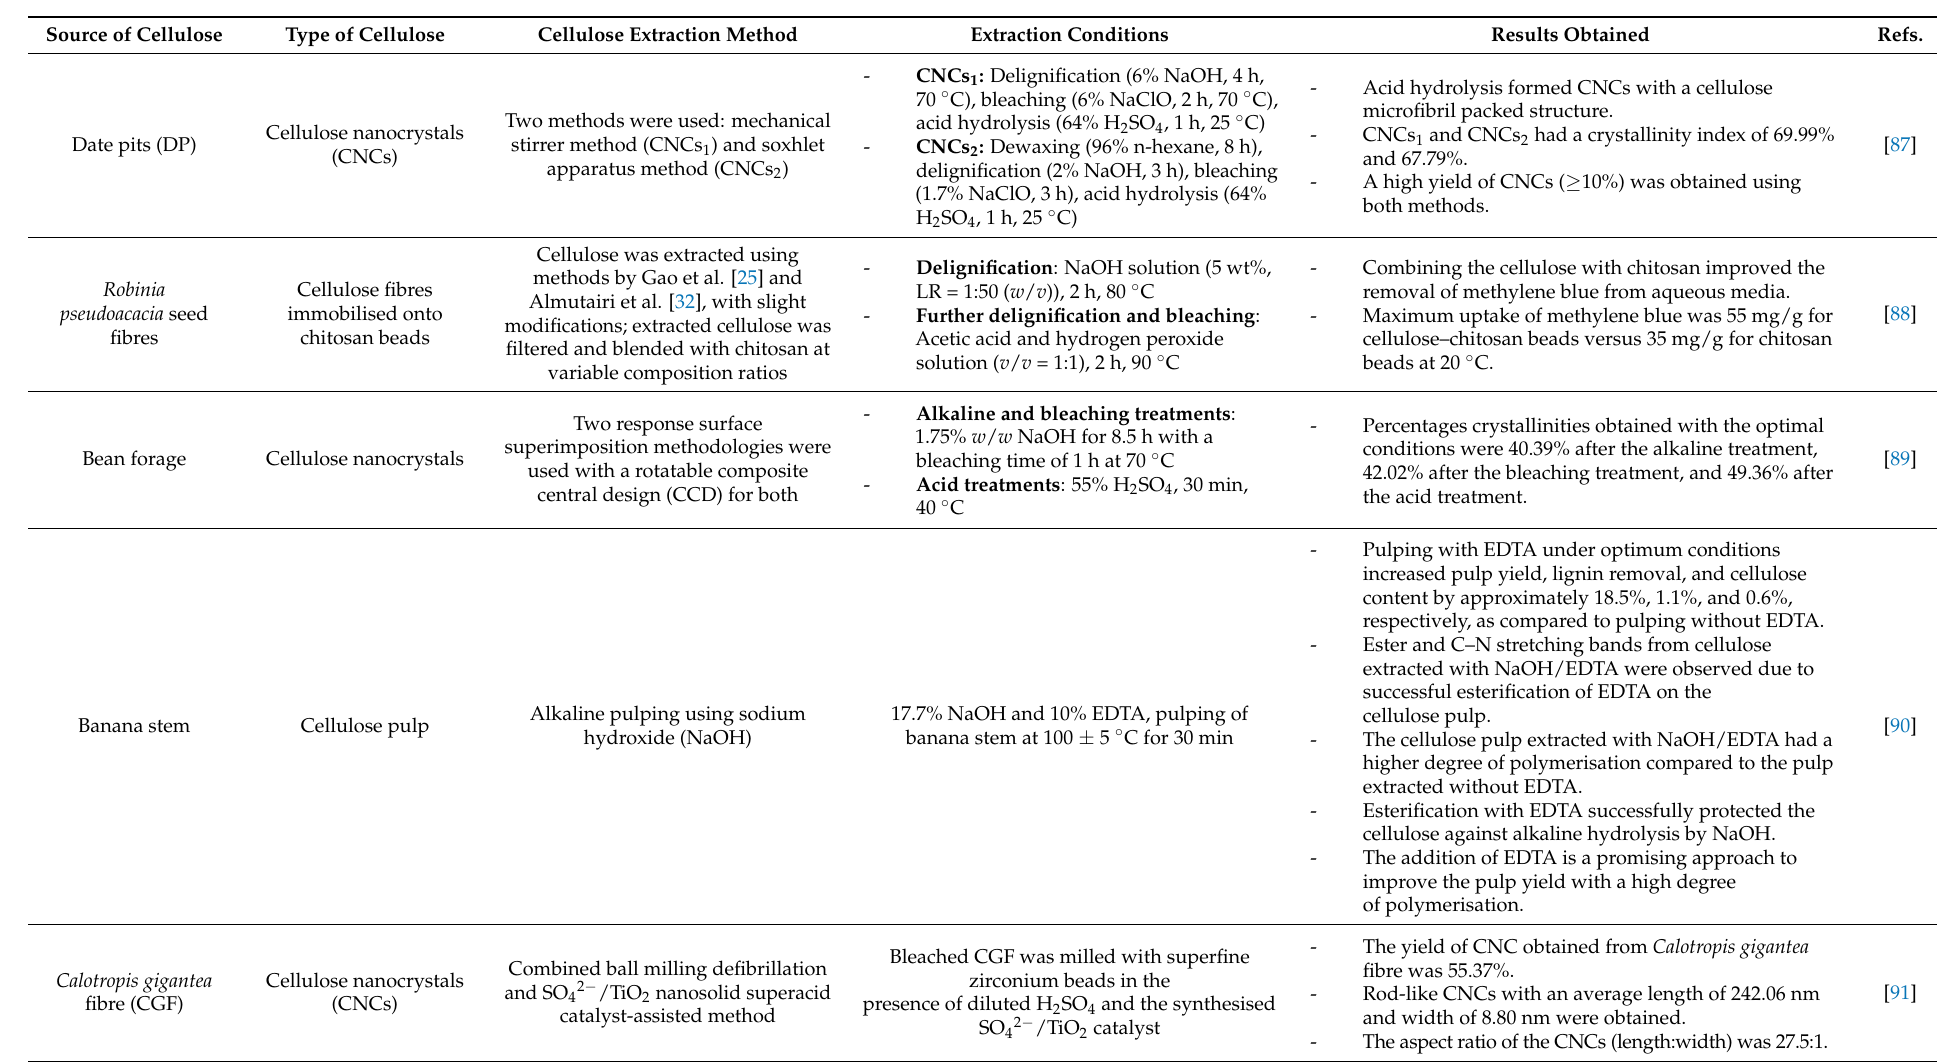
Table 1. Selective studies on the extraction of cellulose from various